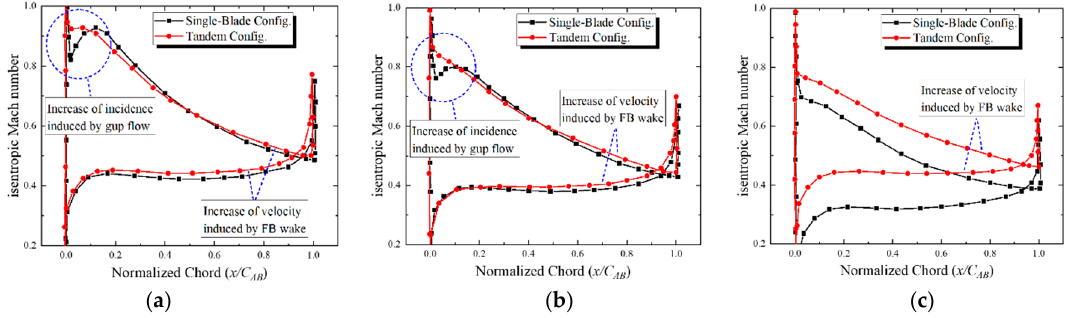
Figure 10. Comparison of the AB isentropic Mach number in single-blade and tandem configurations.